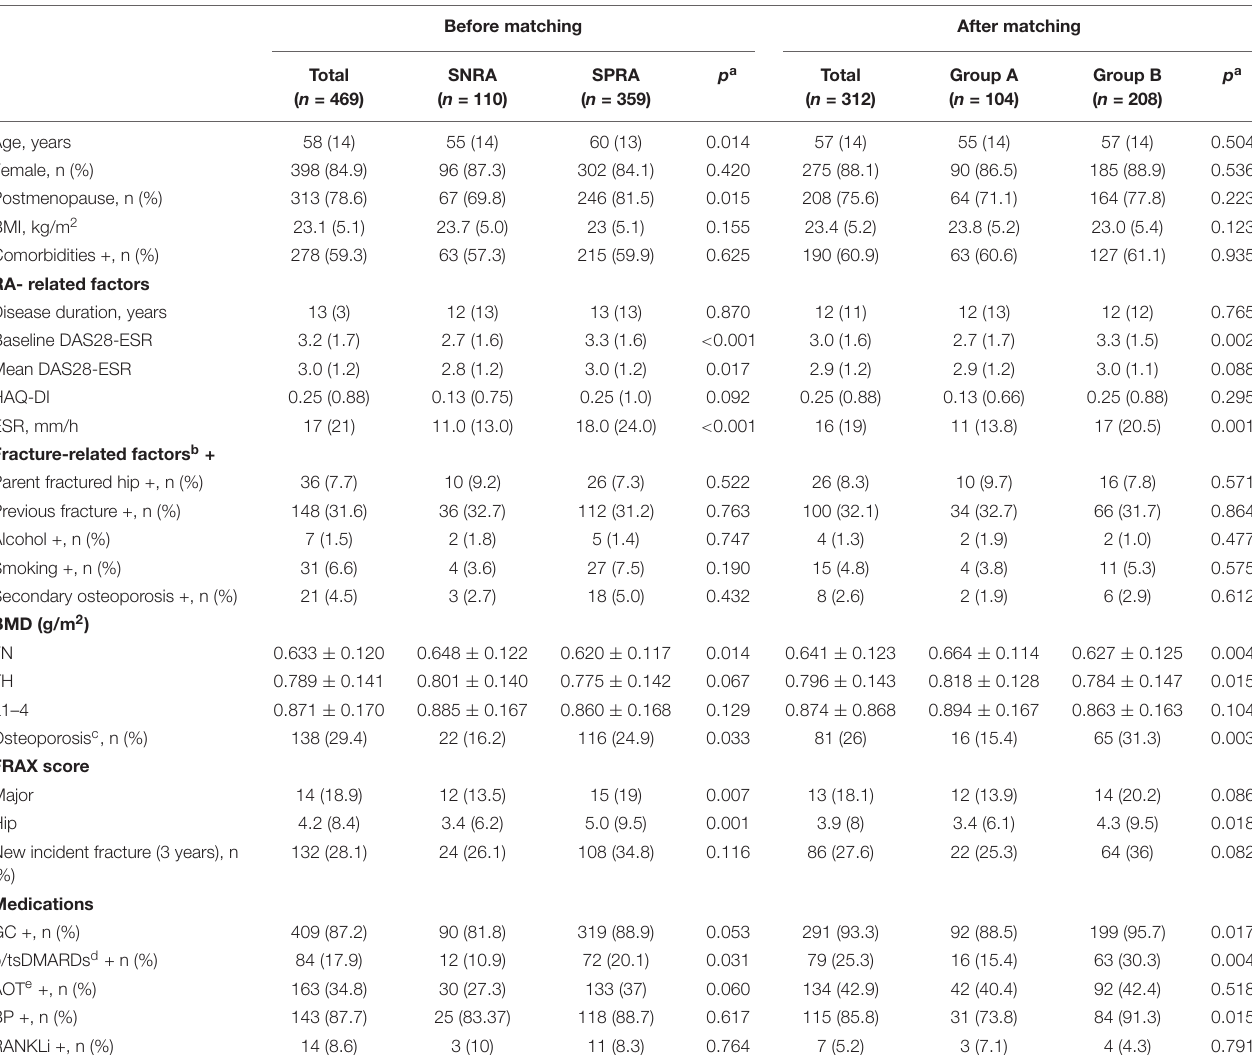
TABLE 1 | Clinical characteristics of participants before and after matching.